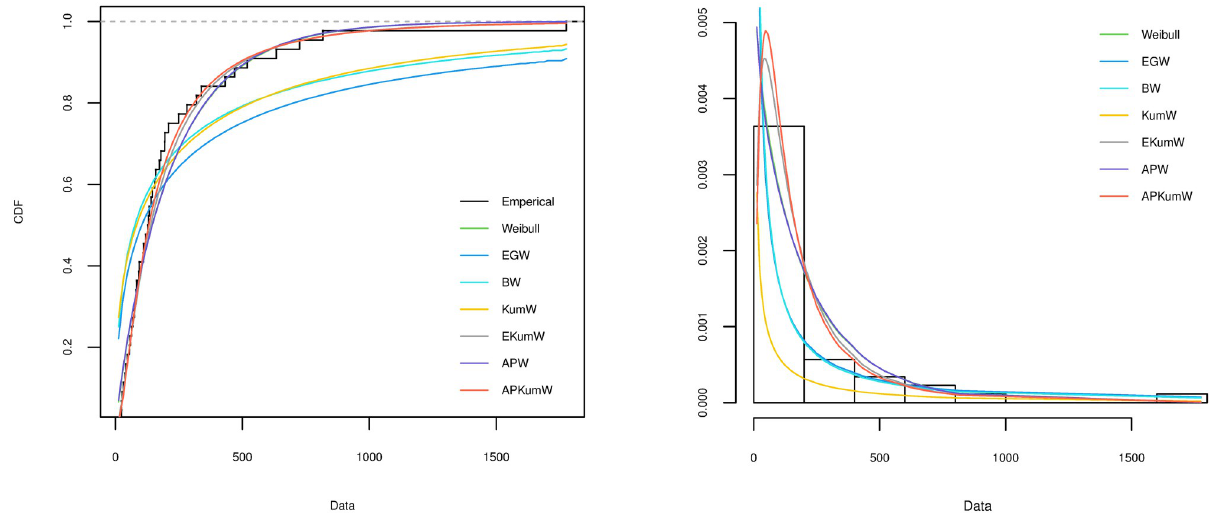
Fig 3. Theoretical and empirical cdf and pdf comparison of the head and Neck cancer data.